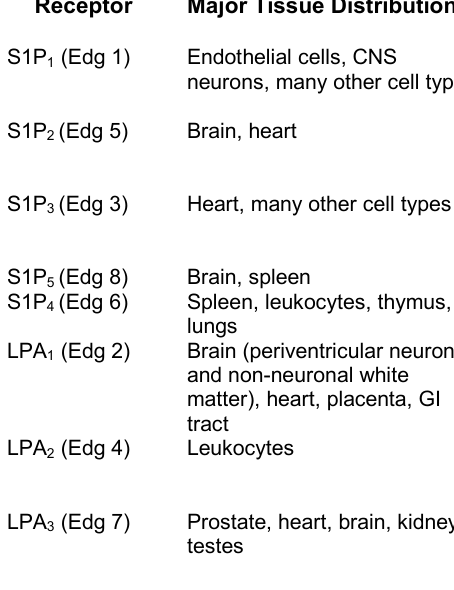
Human Edg Receptor Distribution and Their Pathophysiological Roles